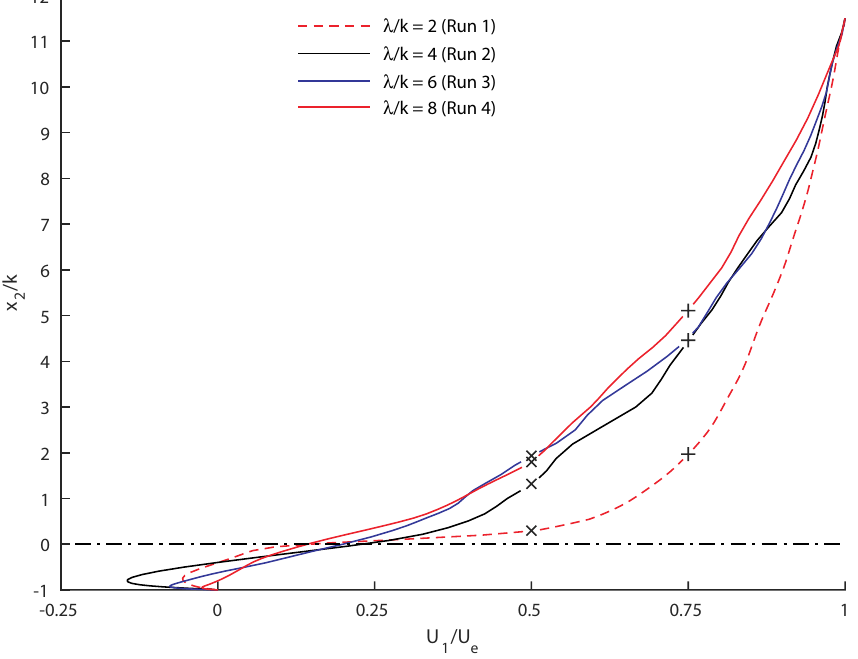
Figure 19. Vertical profiles of U 1 / U e at the middle between adjacent roughness elements, in the channel-center plane x 3 = 0.0375